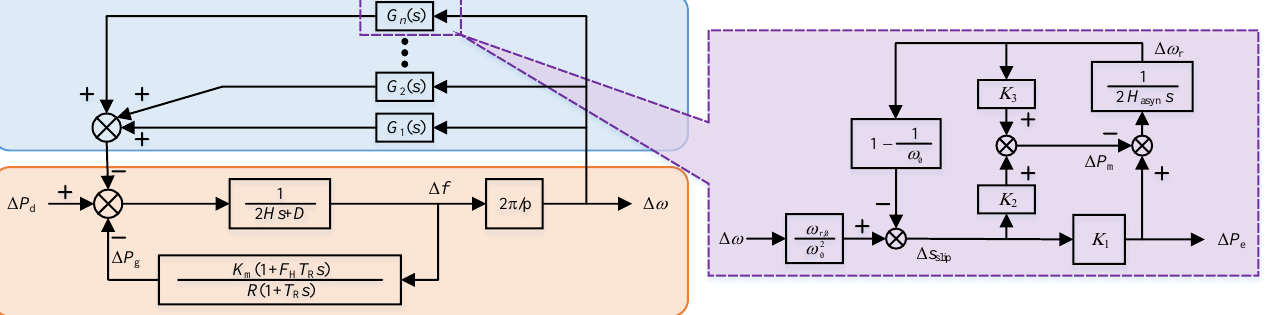
Figure 5. Block diagram of the detailed grid frequency response model considering multiple induction